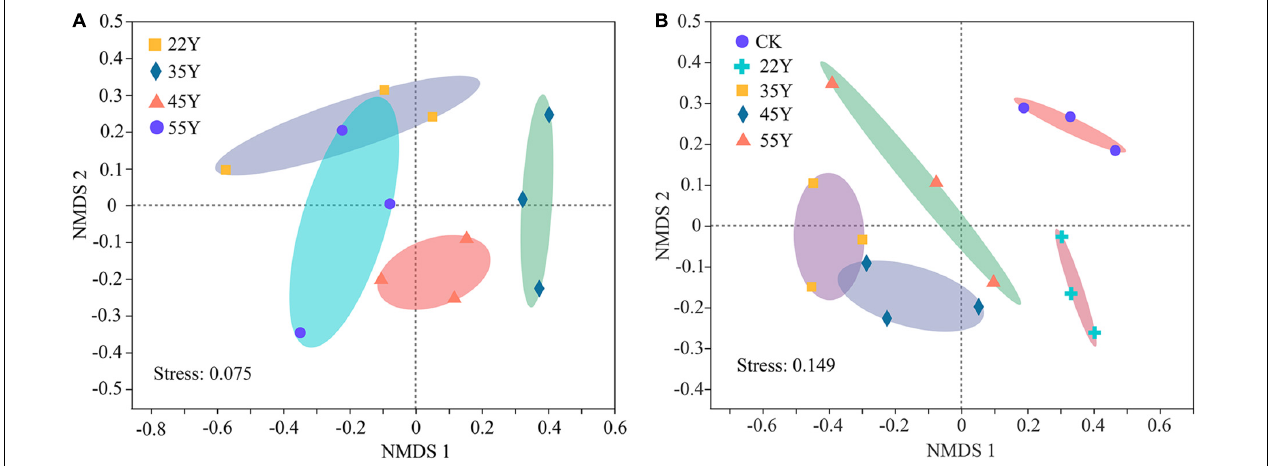
FIGURE 6 | Non-metric multidimensional scaling (NMDS) ordinations of the AM fungal community compositions (Bray-Curtis) in the roots (A) and the rhizosphere soil (B) based on the abundance of OTUs among different stand ages. 22Y, 22-year stand; 35Y, 35-year stand; 45Y, 45-year stand; 55Y, 55-year stand; CK, control.